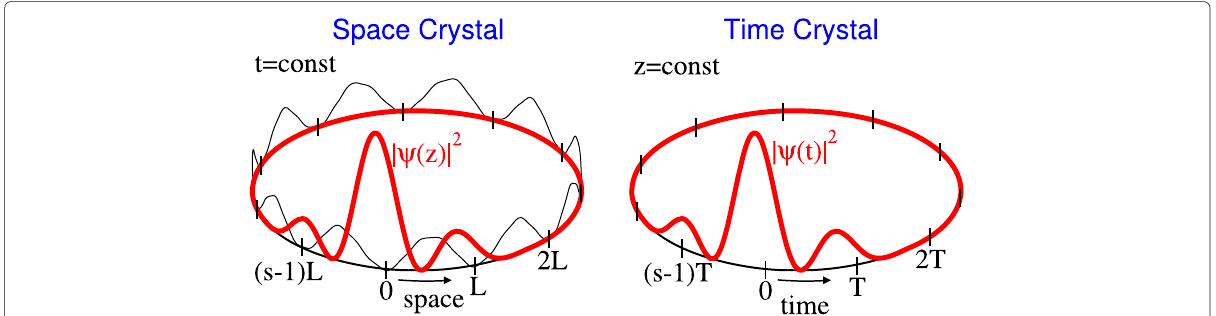
Fig. 3 Comparison of Anderson localization in a 1D space crystal with periodic boundary conditions (left) with Anderson localization in the time domain (right). A particle moving in the space crystal with disorder can Anderson localize, i.e., if we go around the ring, we observe an exponential localization of a particle around a certain space point. Switching from Anderson localization in space to Anderson localization in time, we have to exchange the role of space and time. We fix the position in space and ask if the probability of clicking of a detector is exponentially localized around a certain moment of time—such behavior is repeated periodically due to the periodic boundary conditions in time. This circulating ring system is equivalent to an atom bouncing resonantly on an oscillating mirror. Reprinted from